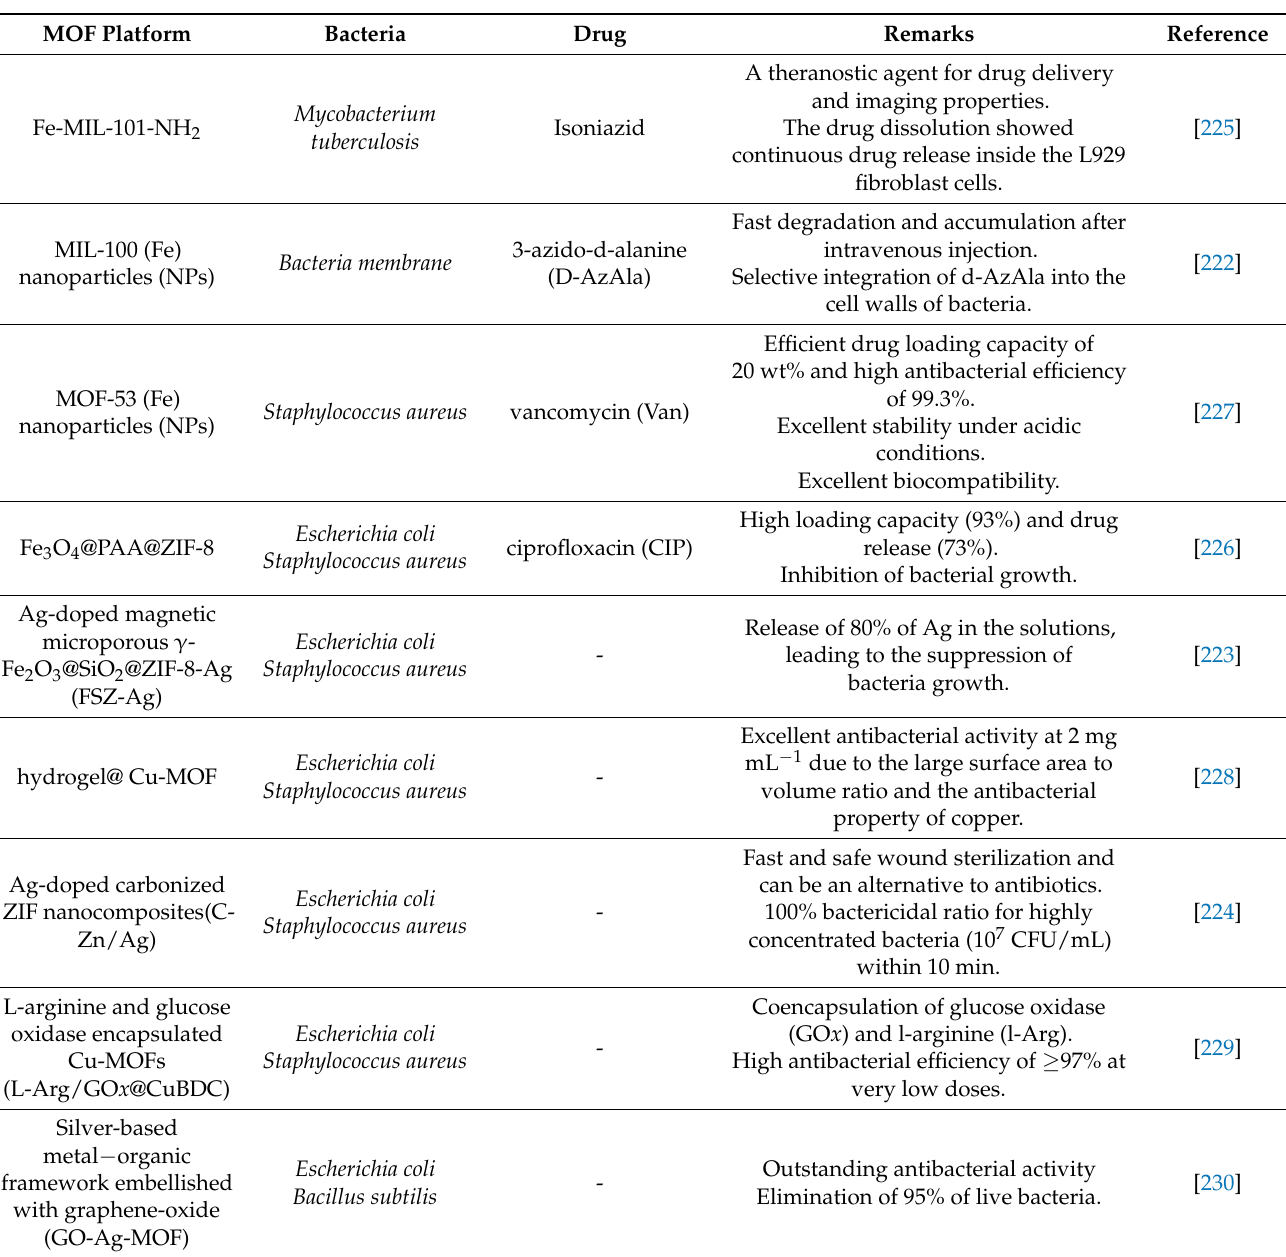
Table 7. Examples of MOF therapeutic platforms for antibacterial